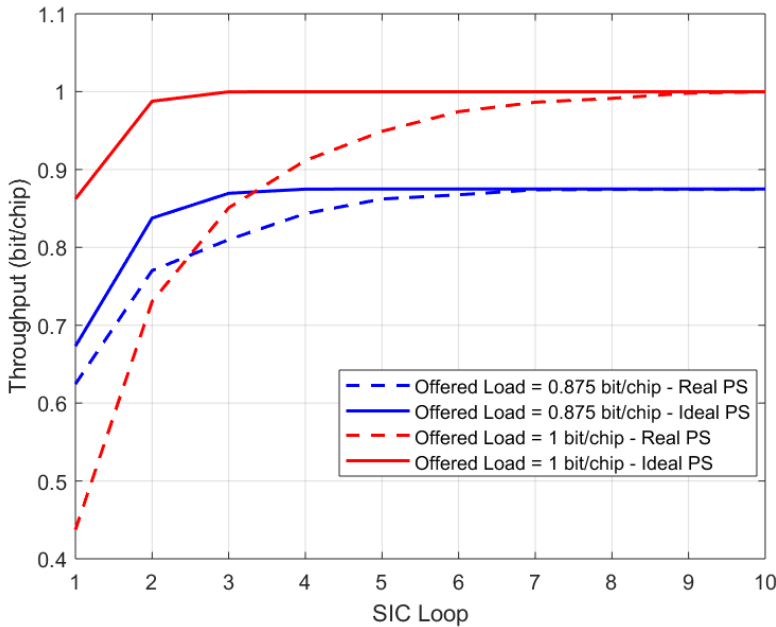
Figure 18. Simulated ME-SSA throughput performance without PR, 3GPP FEC coding rate 1/3 with block size of 1200 bits, spreading factor of 16 and E s /N 0 = 6 dB, for both ideal and actual demodulator preamble searchers (PSs).